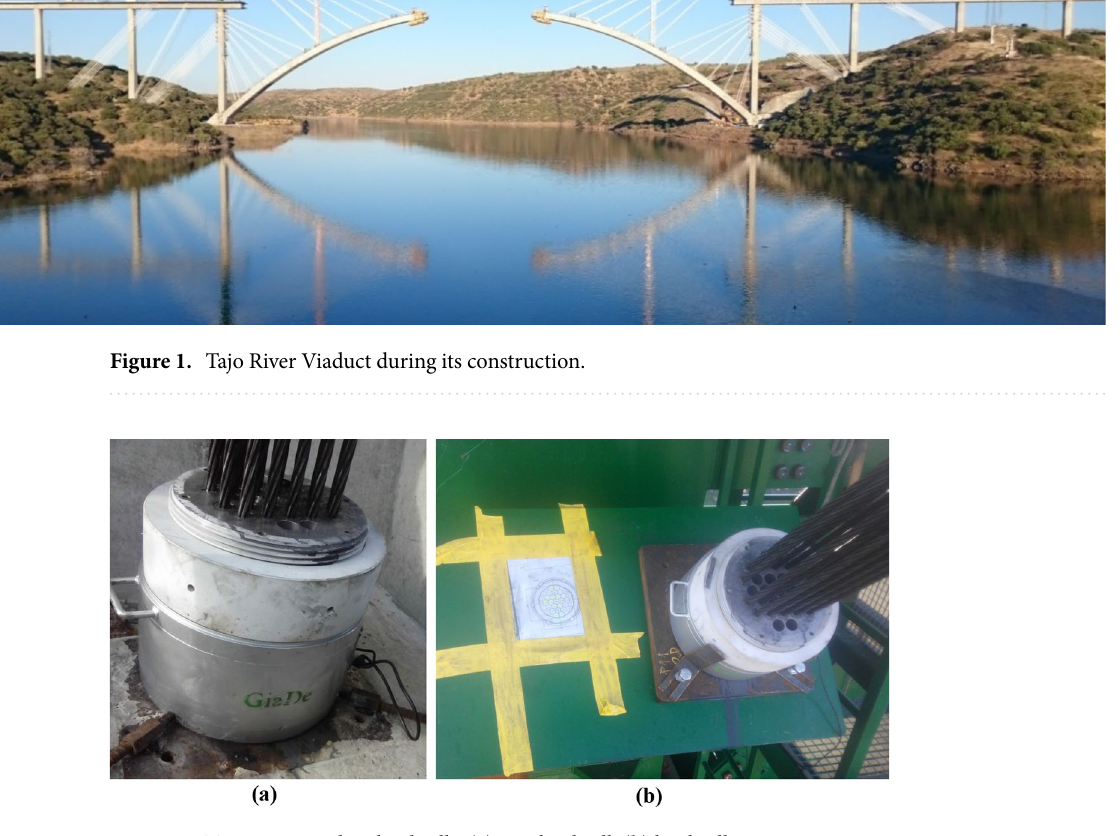
Figure 2. Tajo River Viaduct load cells: ( a ) pier load cell; ( b ) load cell in temporary stay